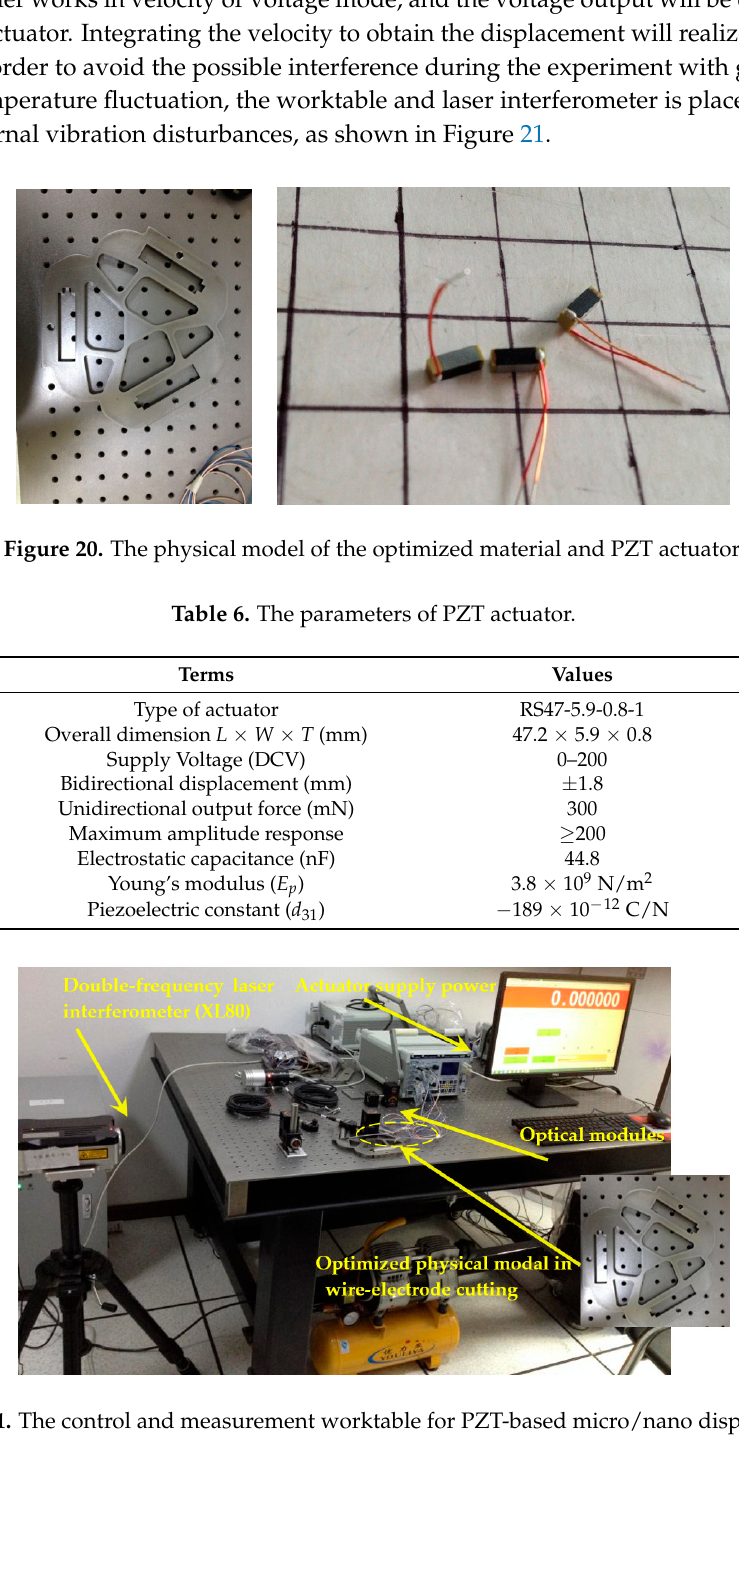
Figure 21. The control and measurement worktable for PZT-based micro/nano displacement.